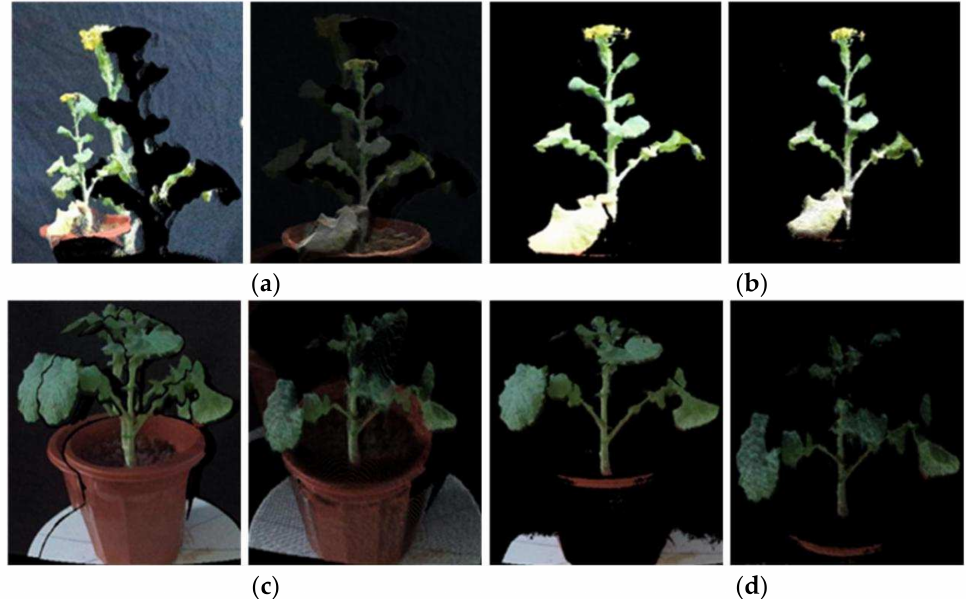
Figure 5. RGB-D image alignment test. ( a ) The alignment result and point cloud by using the official software development kit SDK. ( b ) The results by using the proposed method. ( c , d ) are the other examples of rapeseed